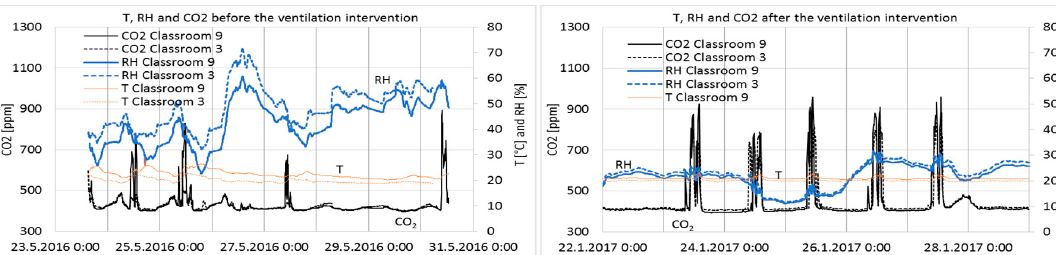
Figure 6. Temperature, relative humidity, and CO 2 concentration in Classrooms 3 and 9 one week before and after the ventilation intervention.